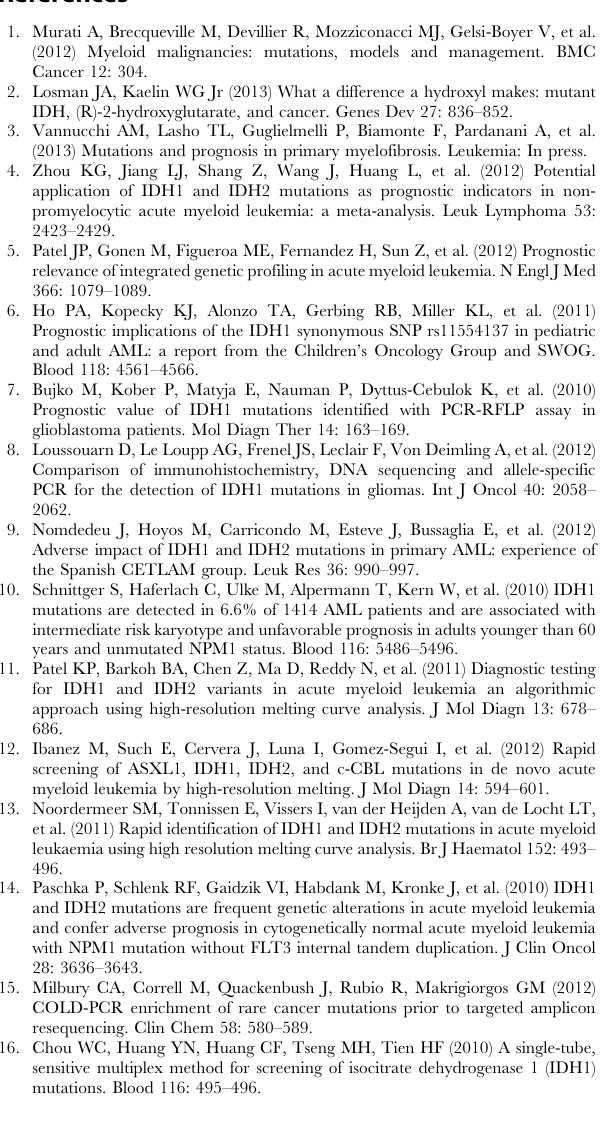
Wallis test). (B) Distribution of the R 2 values for all mutants at the three different temperatures (p=0.507 on Kruskal-Wallis test). Table S1 Comparison of the performance parameters of three curve fitting models for all mutants at the 68 6 C hybridization